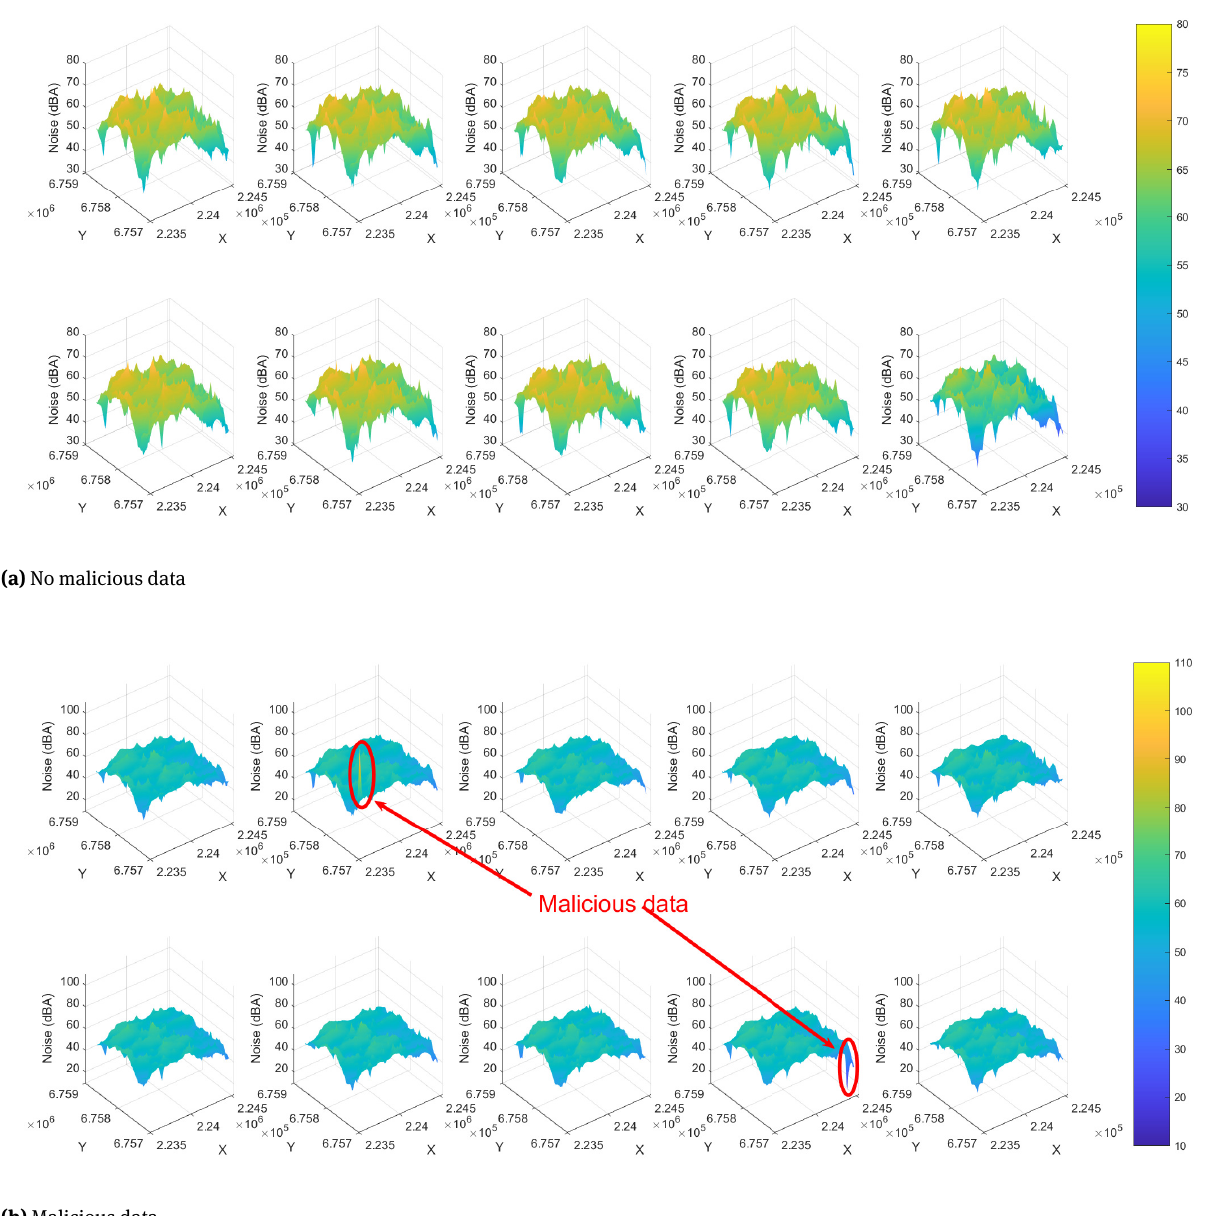
Figure 5: Partial noise maps consisting of no malicious data and two sets of malicious data